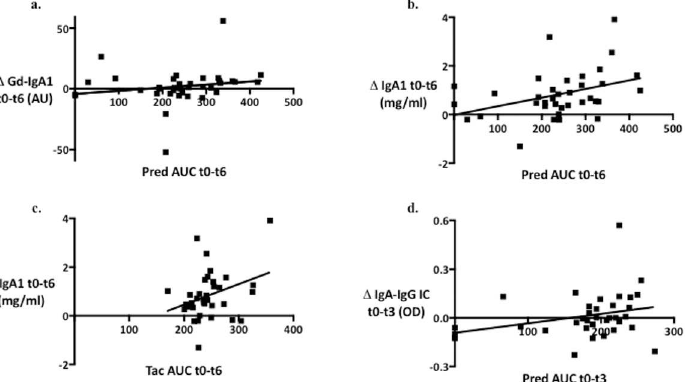
Fig 3. Associations of a . AUC t 0-6 of prednisone and the degreeof reduction of serum Gd-IgA1 betweent 0 and t 6 (p = 0.01); b. AUC t 0-6 of prednisone and the degreeof reductionof serum total IgA1 betweent 0 and t 6 (p = 0.0024); c. AUC t 0-6 of tacrolimusand the degreeof reduction of serum total IgA1 betweent 0 and t 6 (p = 0.02) ; d. AUC t 0-3 of prednisone and the degreeof reduction of serum IgA-IgG complexesbetweent 0 and t 3 (p = 0.0036).